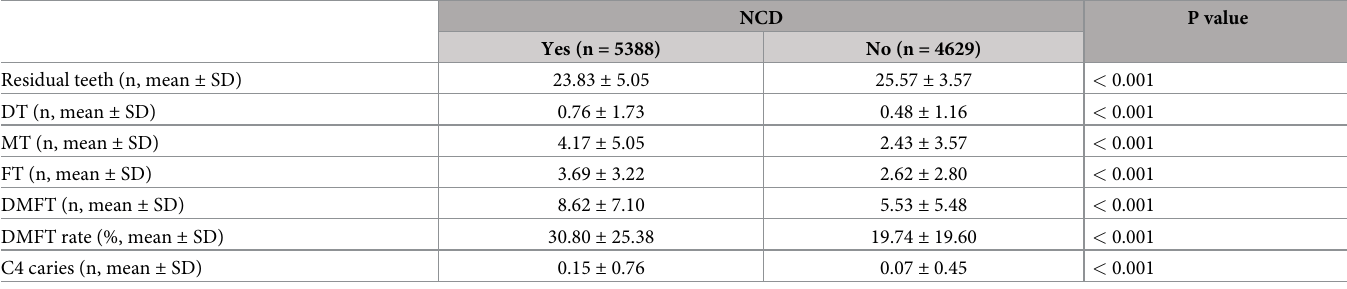
Table 2. Analysis of dental status according to the presence of NCDs.